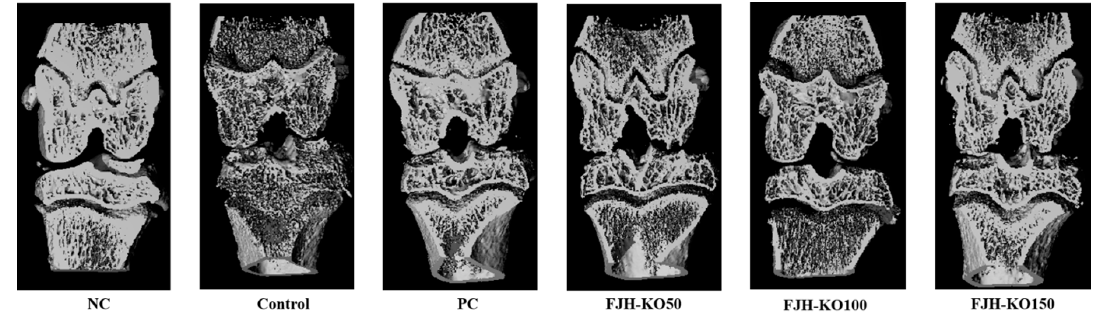
Figure 2 . μ CT analysis of the hind knee joint rats with or without MIANC: AIN93G diet; C: AIN93G Figure 2. µ CT analysis of the hind knee joint rats with or without MIANC: AIN93G diet; C: